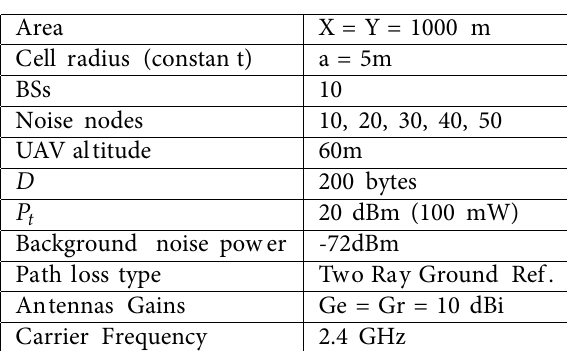
coverage by setting the number of noise nodes to 50 nodes and the drone altitude to 60 m . We compare for all these poin ts the resul ted paths with Dijkstr a’s short path in terms of length and RP R . The comparisons are illustr ated in the figure 14 and 15. Indeed, the gap is importan t in term of RP R . For the computed paths,